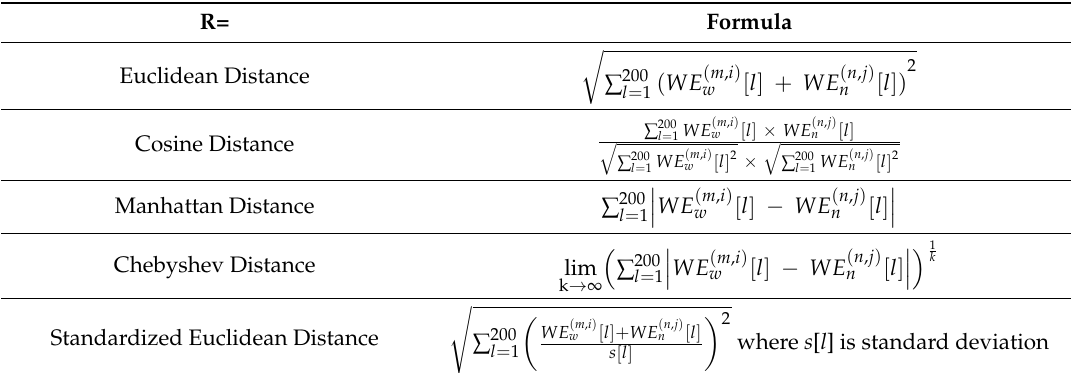
Table 1. Formulas of the words vector